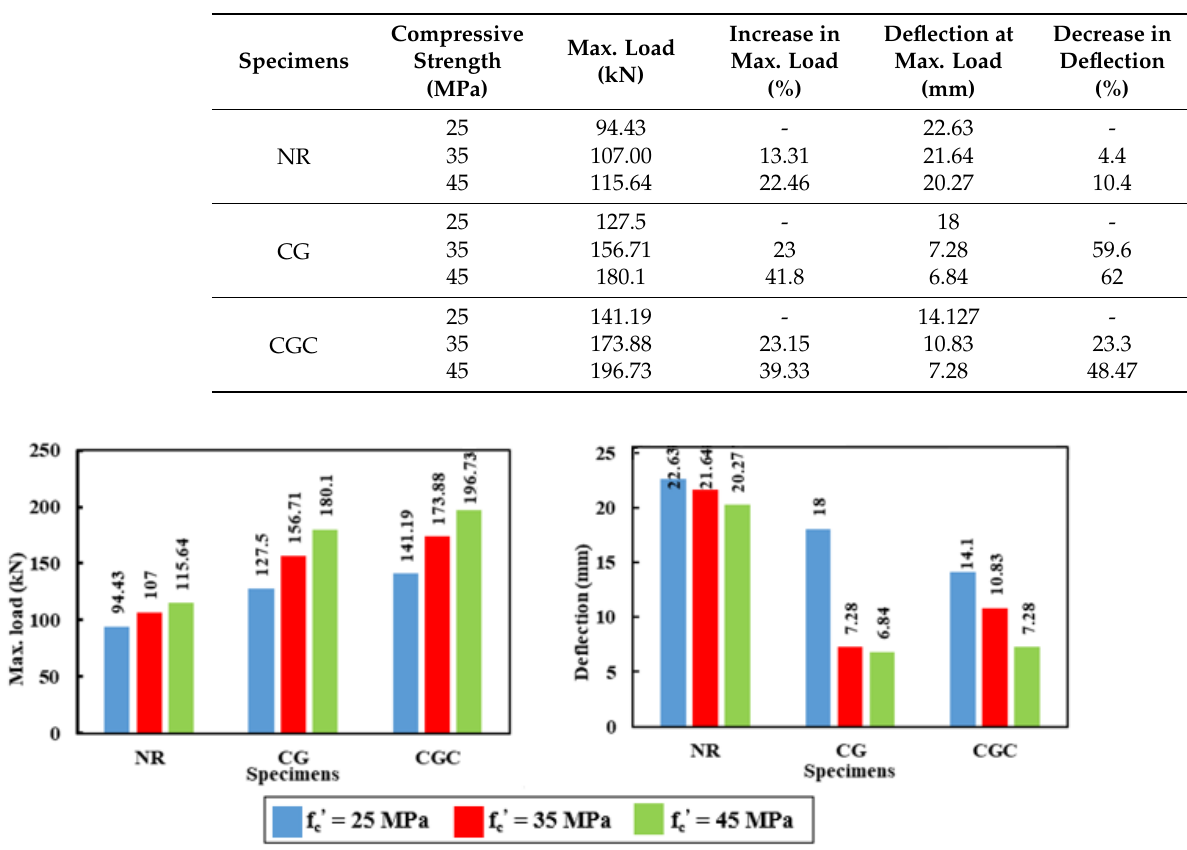
Figure 19. The effect of concrete compressive strength on the ultimate load capacity and correspond- ing deflection for the analyzed specimens.